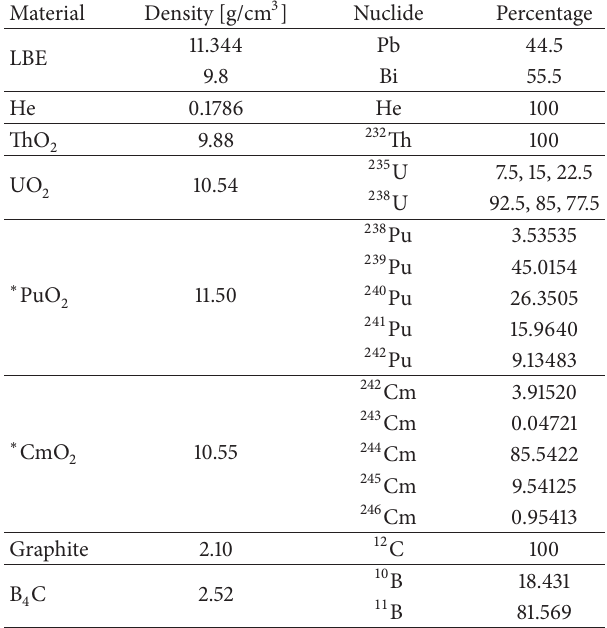
Table 1: Isotopic percentages and densities of the materials used in the investigated ADS.